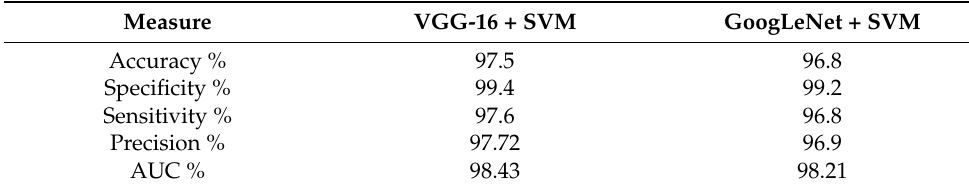
Table 3. Results of the CNN with SVM for cervical cancer data set diagnosis.